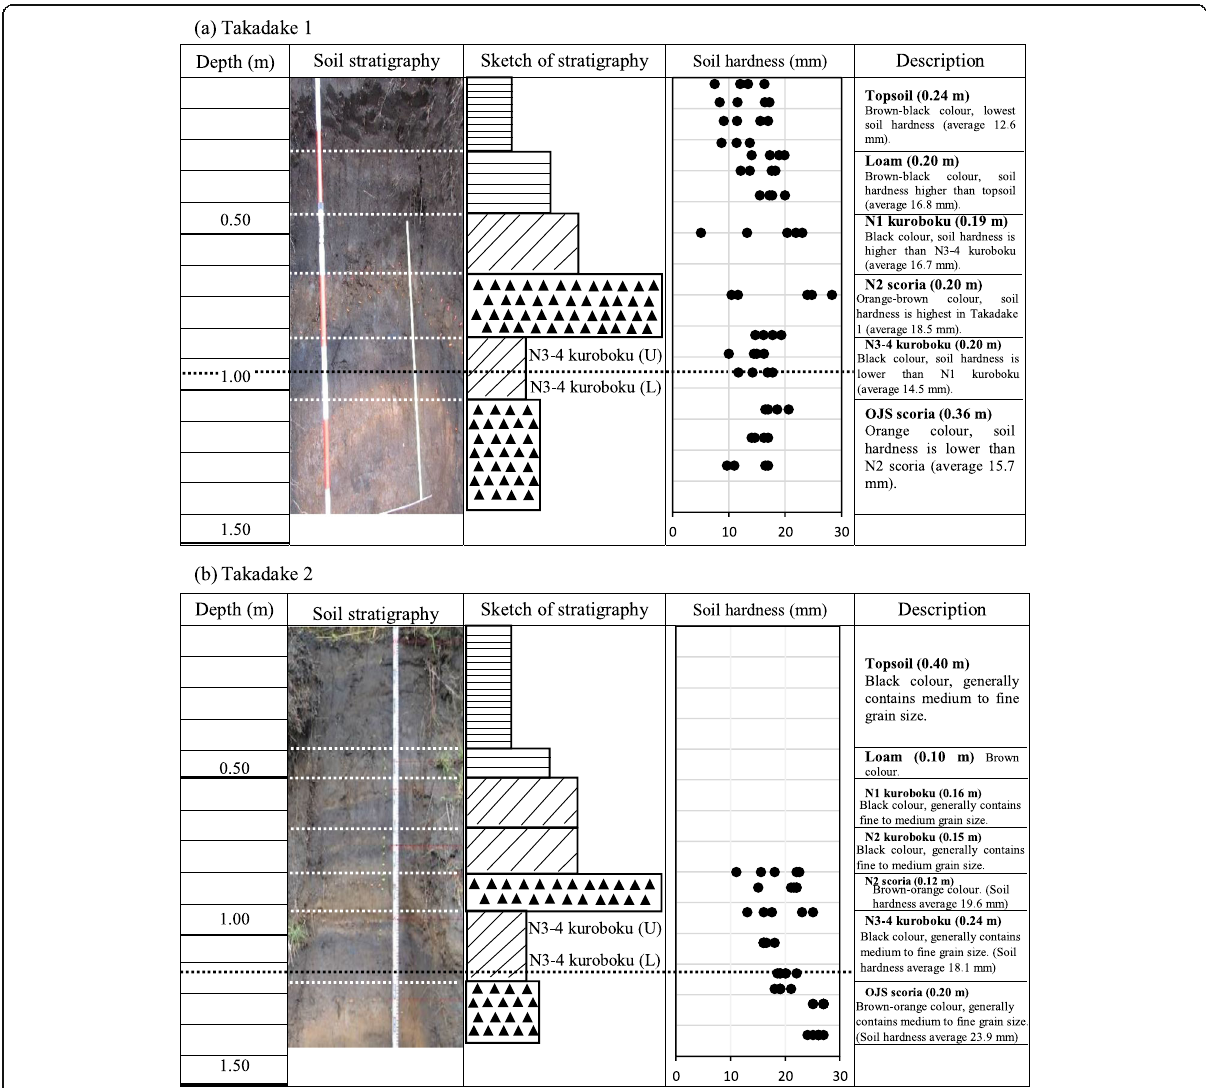
Fig. 2 Soil stratigraphy; dotted lines indicate sliding layer by field